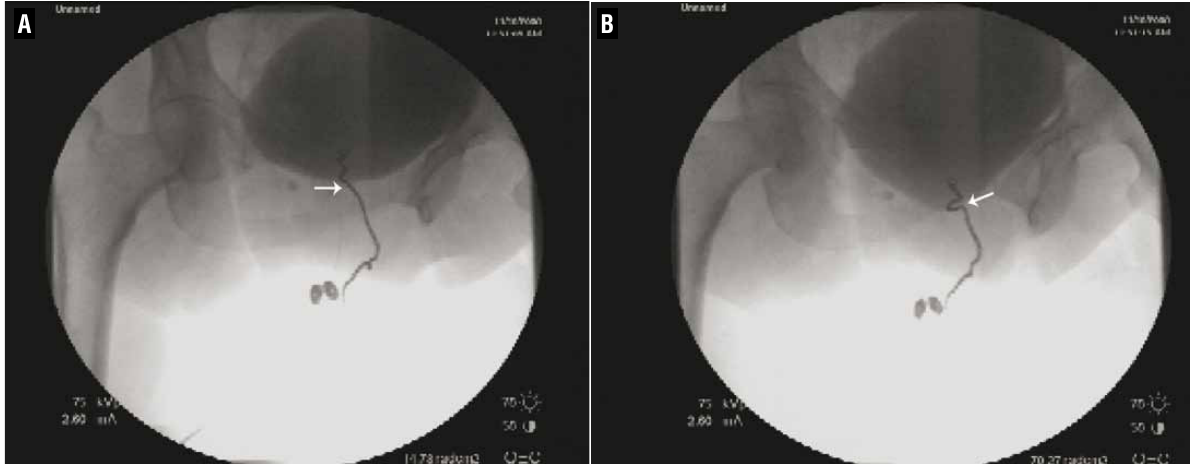
Figure 2a and 2b - shows the chain in position for the VCC and then the chain angulation with the attempted voiding during the VCC. Figure 2a – white arrow shows chain in urethra with the patient relaxed. Figure 2b - white arrow shows angulation of chain, consistent with obstruction during voiding attempt with VCC.